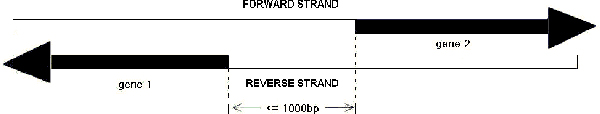
A sketch map of bidirectional promoter. Gene 1 and gene 2 are from the same chromosome, and gene 1 is on the reverse stand while gene 2 is on the forward one. The distance between their transcription start sites (TSSs) is not more than 1000 base pairs. Gene 1 and gene 2 are called "bidirectional genes" and "bidirectional promoter" refers to the intergenic region separating "bidirectional genes" generally.